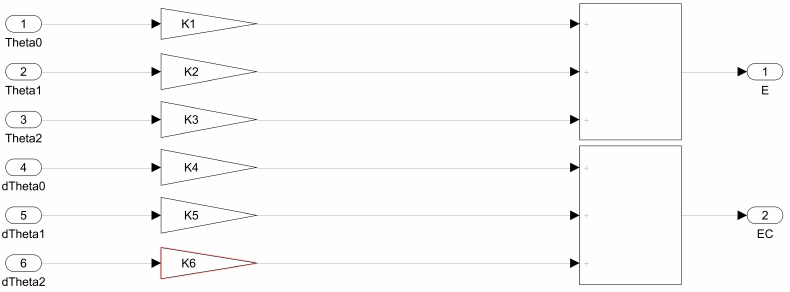
Figure 15. The fusion